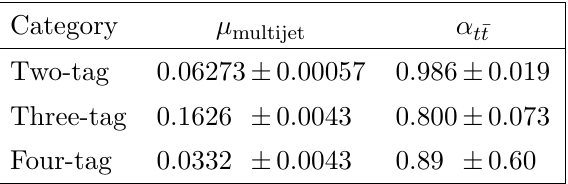
Table 4. The (cid:12)tted values of (cid:22) multijet and (cid:11) statistical uncertainties are shown as